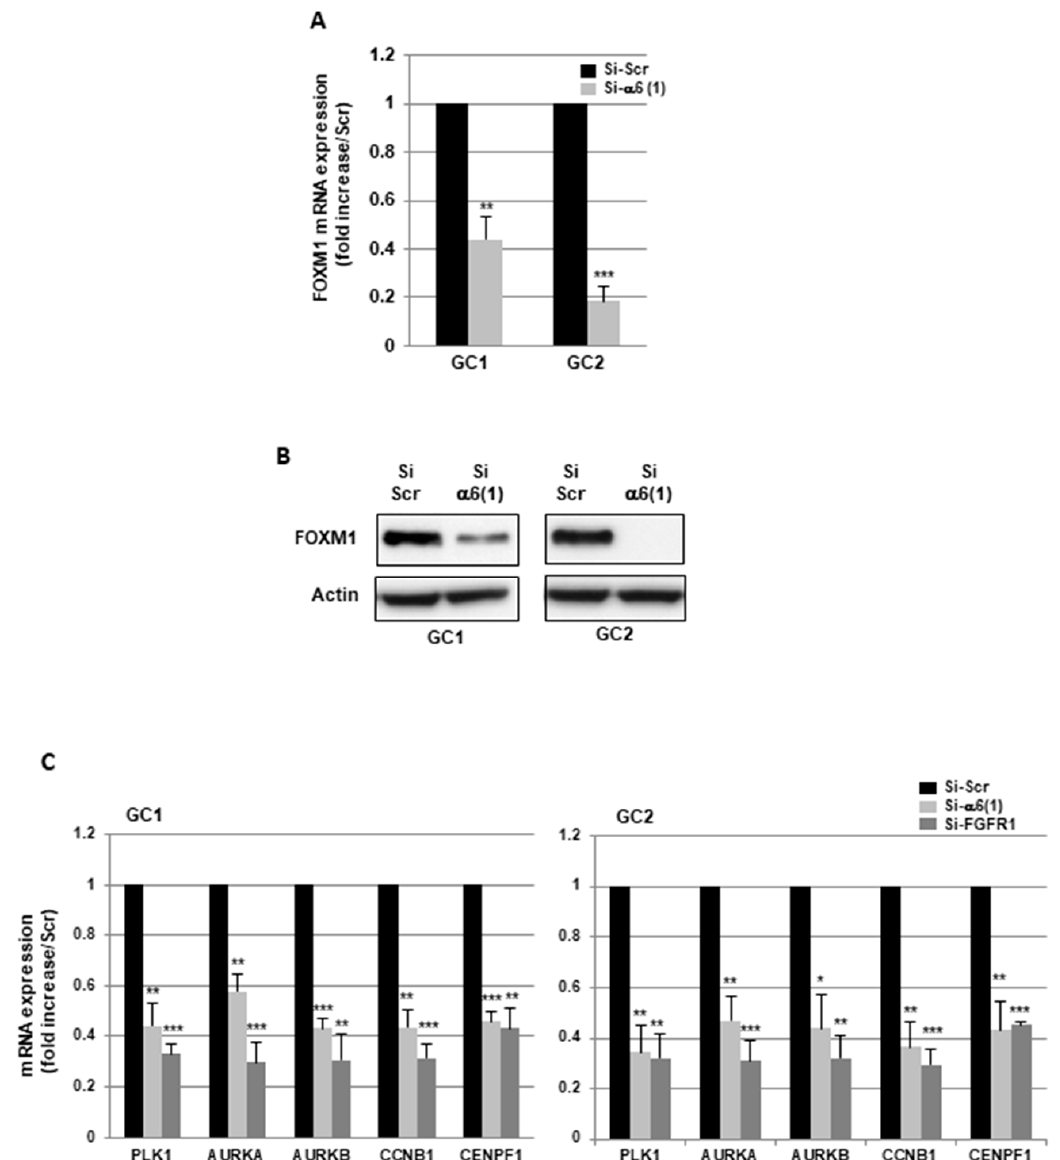
Figure 2. Down-regulation of α 6-integrin inhibits the expression of the transcription factor, FOXM1, and its downstream targets. ( A – C ) GBMSC derived from GBM biopsy specimens (GC1, GC2) were transfected with an α 6-integrin siRNA (si- α 6 (1)), a specific FGFR1 siRNA (si-FGFR1), or a scramble control (si-Scr). ( A , C ) The expression of FOXM1 and its downstream target genes were analyzed using real-time PCR. Quantifications of 3 independent experiments are presented as means ± SD. *** p < 0.001; ** 0.001 < p < 0.01; * 0.01 < p < 0.05. ( B ) FOXM1 protein expression was analyzed using Western blot. Images are representative of 3 independent experiments. Actin was used as a loading control.